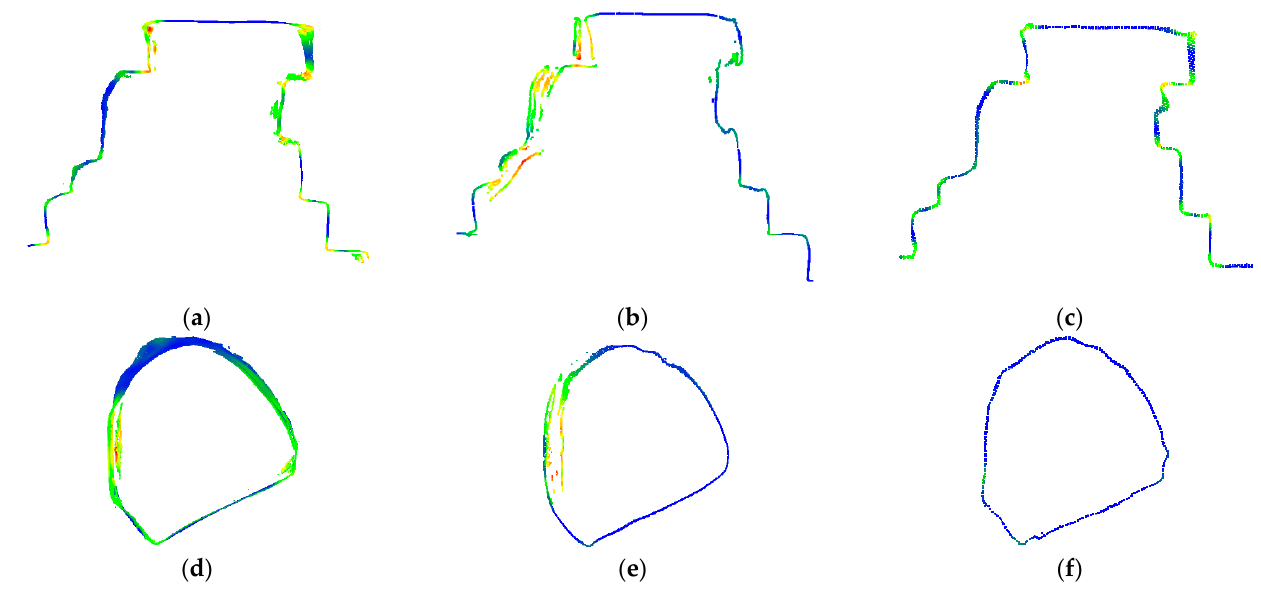
Figure 14. Sections of the point cloud in the closure zones: vertical section (A-A) of the point cloud with resolution 1 cm ( a ), vertical section (A-A) of the point cloud with resolution 1.5 cm ( b ), vertical section (A-A) of the point cloud with resolution 2 cm ( c ), horizontal section (B-B) of the point cloud with resolution 1 cm ( d ), horizontal section (B-B) of the point cloud with resolution 1.5 cm ( e ), horizontal section (B-B) of the point cloud with resolution 2 cm ( f ).